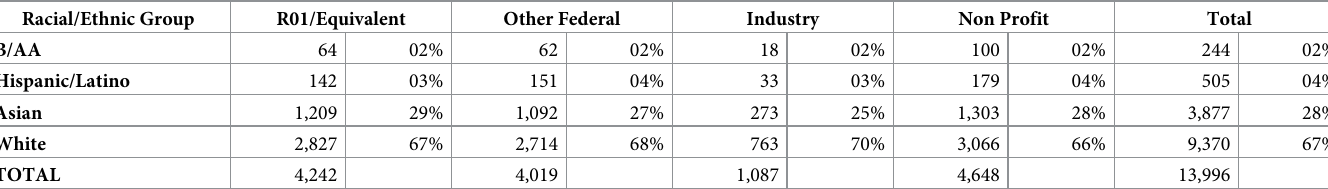
Table 4. Number of UMMS submissions by racial/ethnic group and submission category (2010–2022). Racial/Ethnic Group